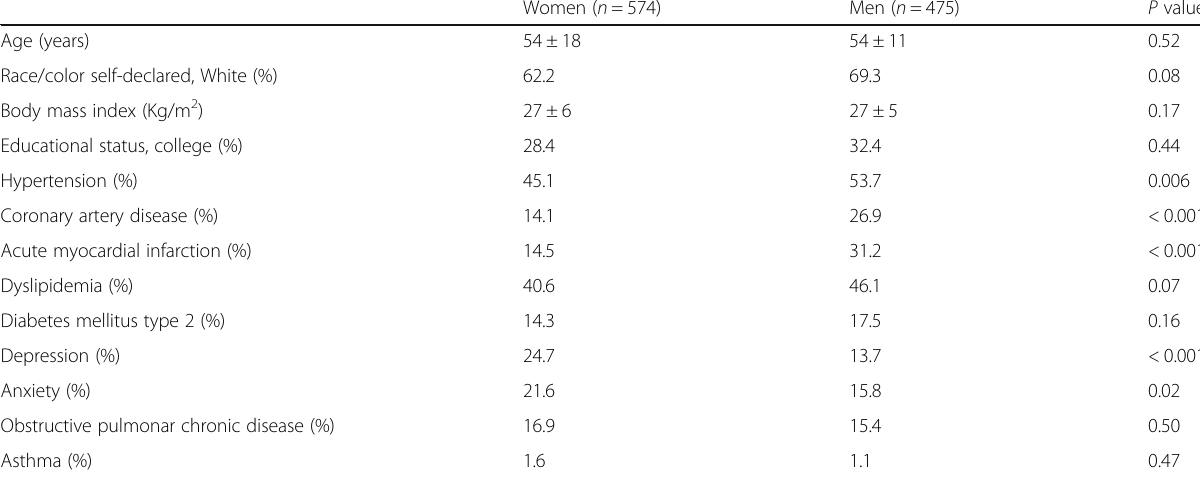
Table 1 Clinical and demographic characteristics of patients undergoing smoking cessation ( n =